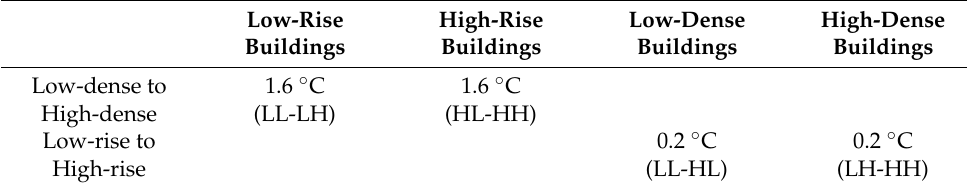
Figure 11. The top panel shows the four typical urban morphology types of LL, HL, LH, and HH ( a – d ); ( e ) Relationship between heat accumulation and average NVCI of four types. Table 7. Heat accumulation in four typical urban morphology